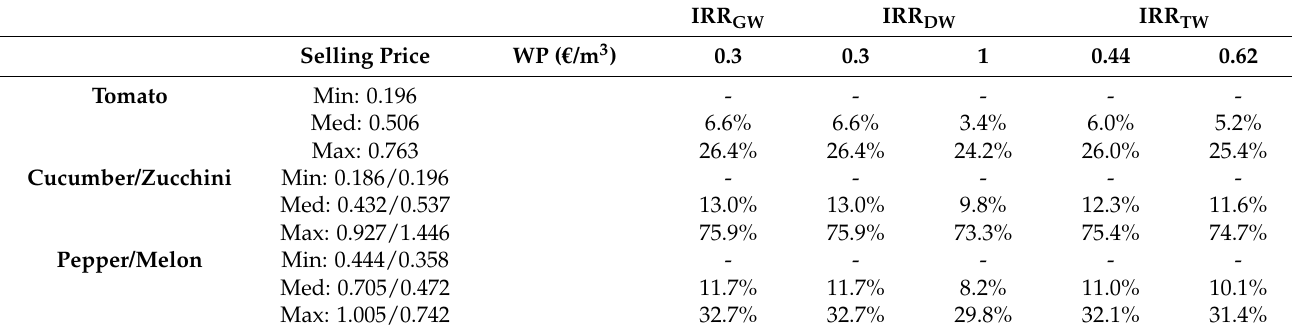
Table 9. IRR of three different crop alternatives with diverse water